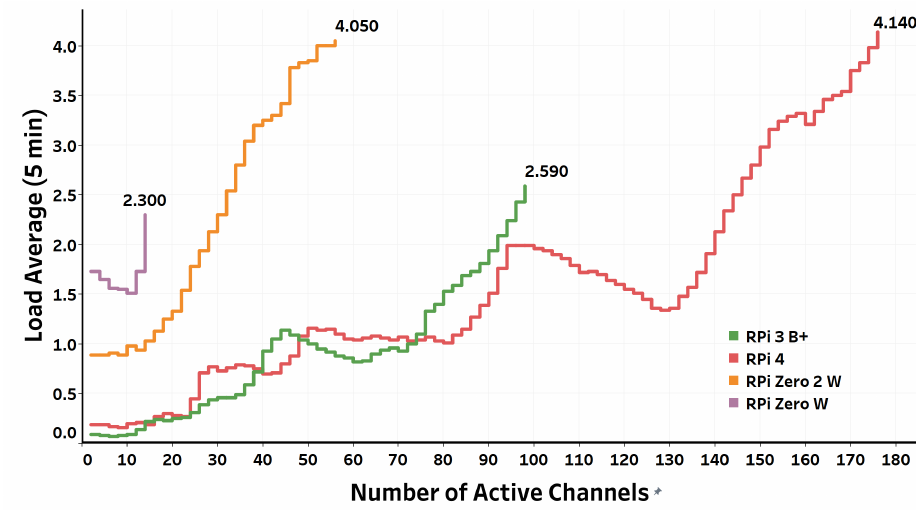
Figure 12. Relation between the number of active channels and the operating system load average (transcoding).